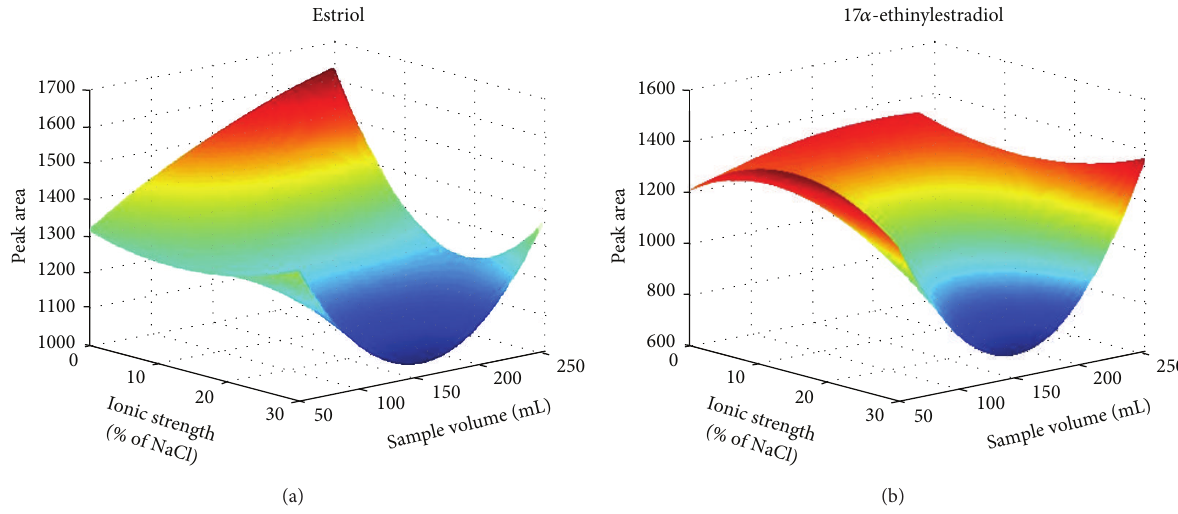
Figure 2: Effect of ionic strength and sample volume on the SPE extraction for estriol and 17 𝛼 -ethinylestradiol.